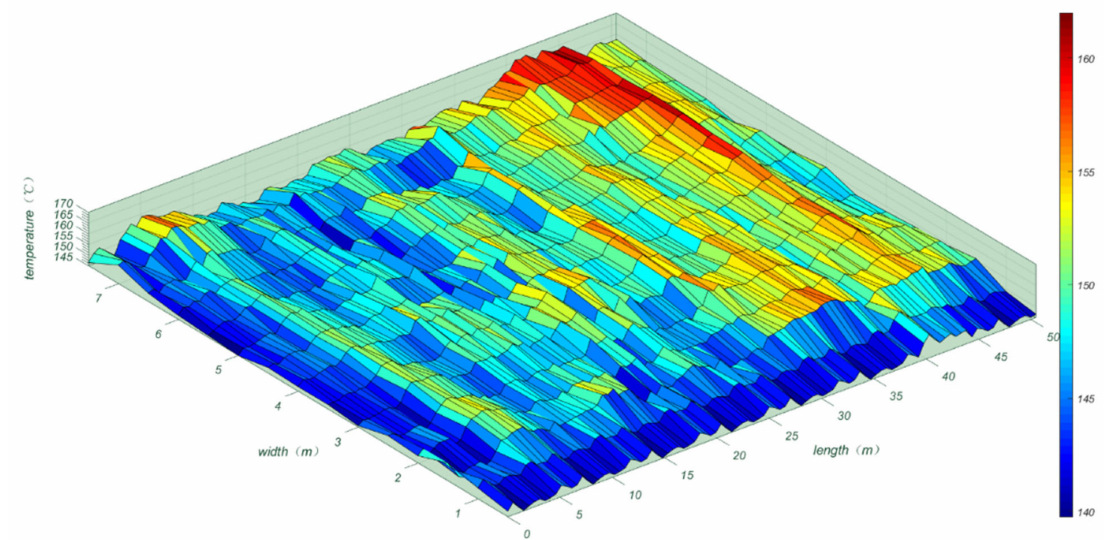
Figure 10. Study area temperature distribution